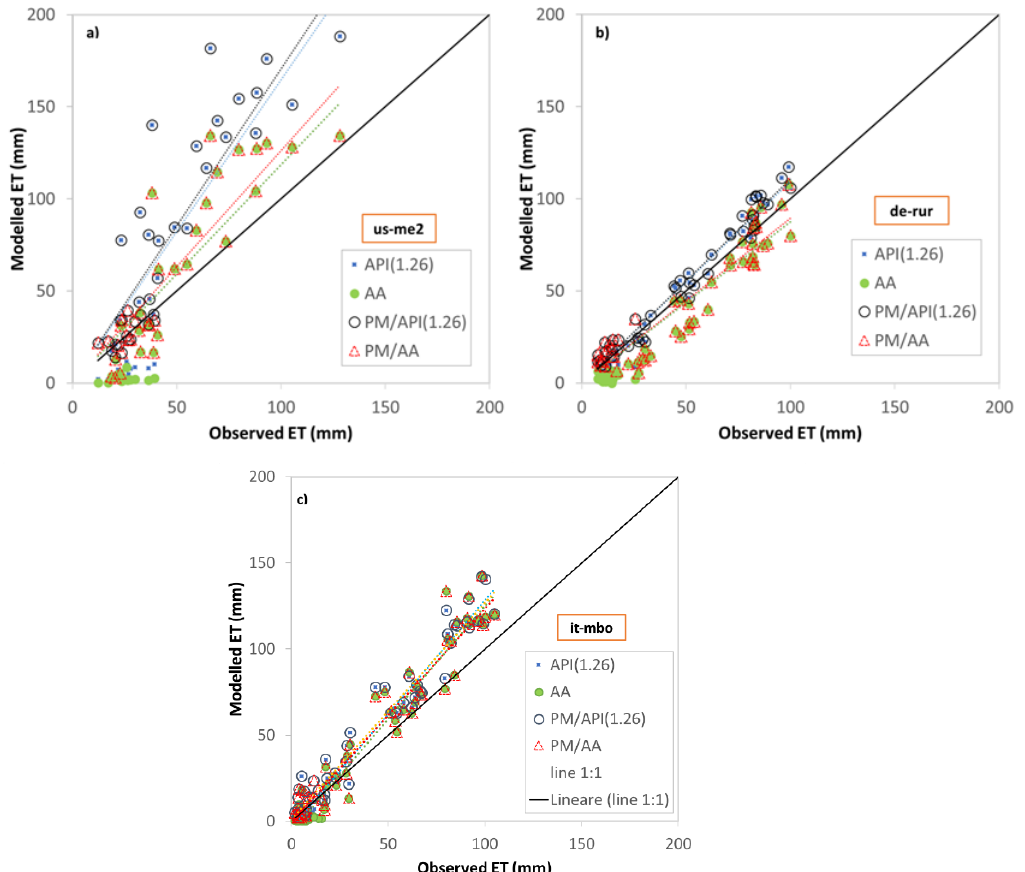
Figure 5. Scatter plots of observed and modelled ET values at the Sister site ( a ), the Rollesbroich site ( b ), and Bondone mountain ( c ). (AA = advection-aridity method; API (1.26) = API corrected potential evapotranspiration, with α = 1.26; PM / AA = Penman / advection-aridity threshold model; PM / API(1.26) = Penman / API corrected potential evapotranspiration threshold model, with α = 1.26).